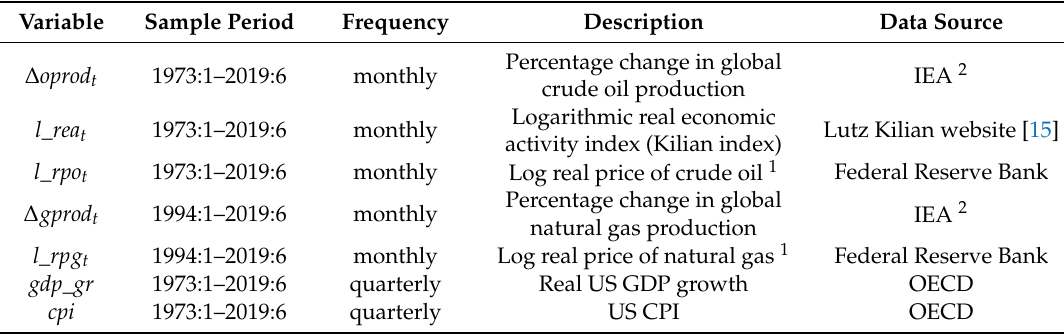
Table 1. Data descriptions and